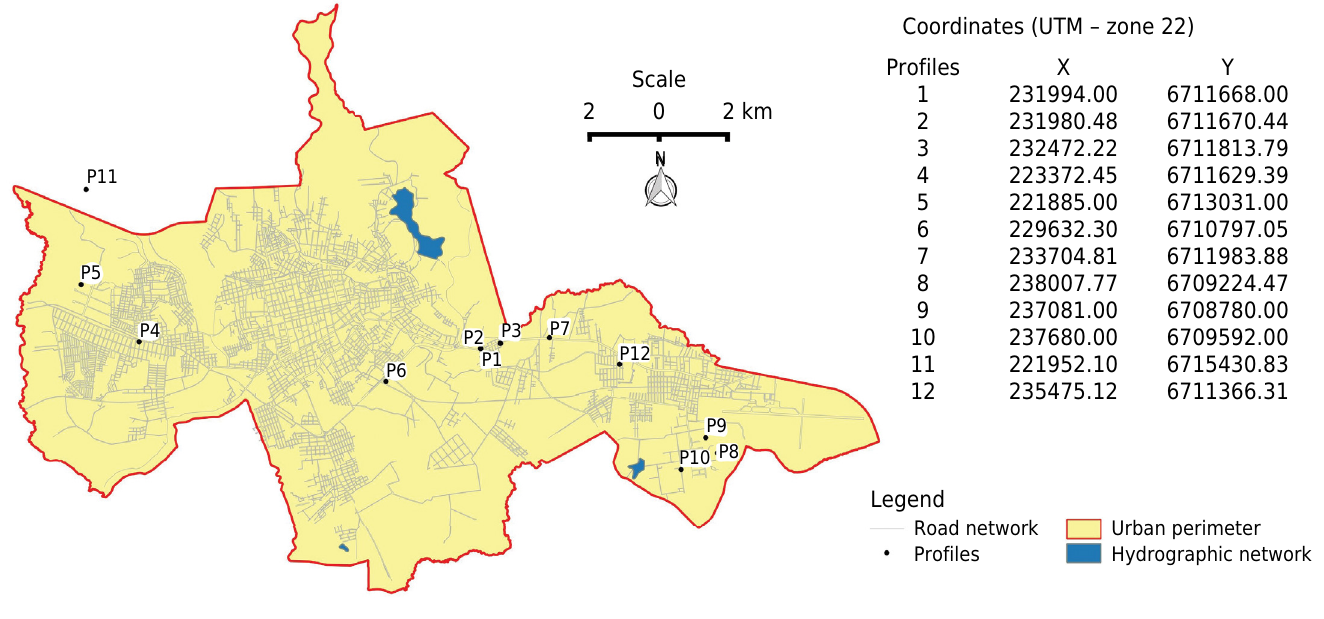
Figure 1. Location of soil profiles evaluated within the urban area of Santa Maria, Rio Grande do Sul State,